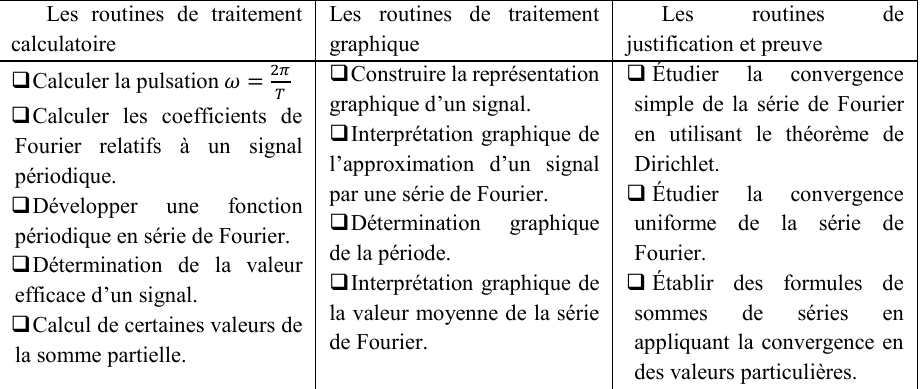
Tableau 3. Les trois catégories des routines visées dans les capsules